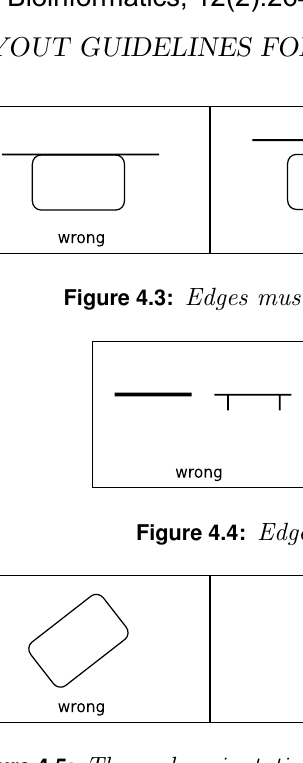
Figure 4.5: The node orientation must be horizontally or vertically.